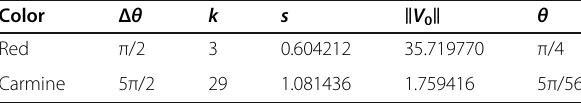
Table 4 The specific data of typical curves with different Δ θ